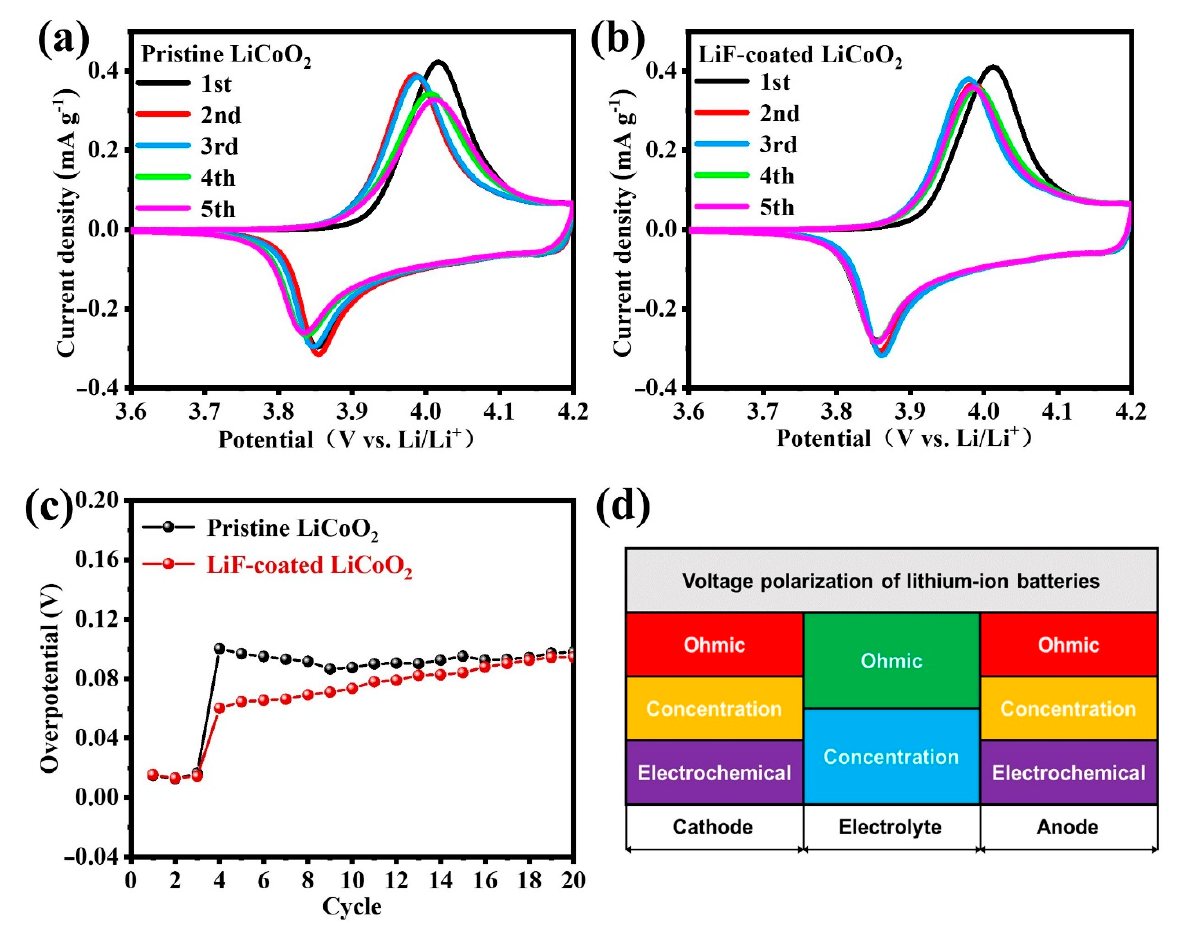
Figure 3. ( a , b ) Cyclic voltammetry curves of pristine LCO and LiF-coated LCO. ( c ) Overpotential of average voltage of pristine LCO and LiF-coated LCO. ( d ) Voltage polarization of lithium-ion batteries for cathode, electrolyte, and anode components.